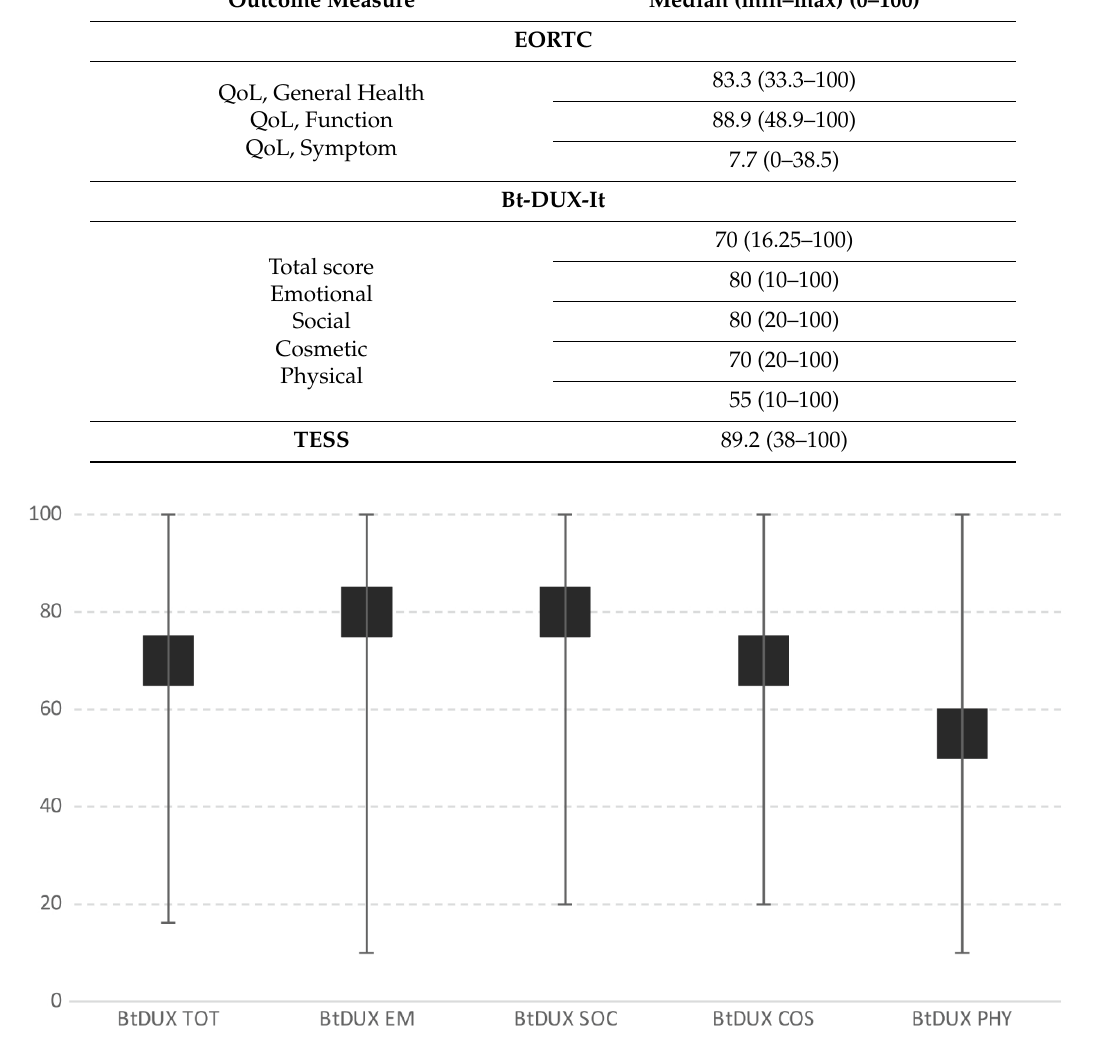
Table 2. Outcome measures. EROTC, the European Organization for Research and Treatment Core; TESS, Toronto Extremity Salvage Score.